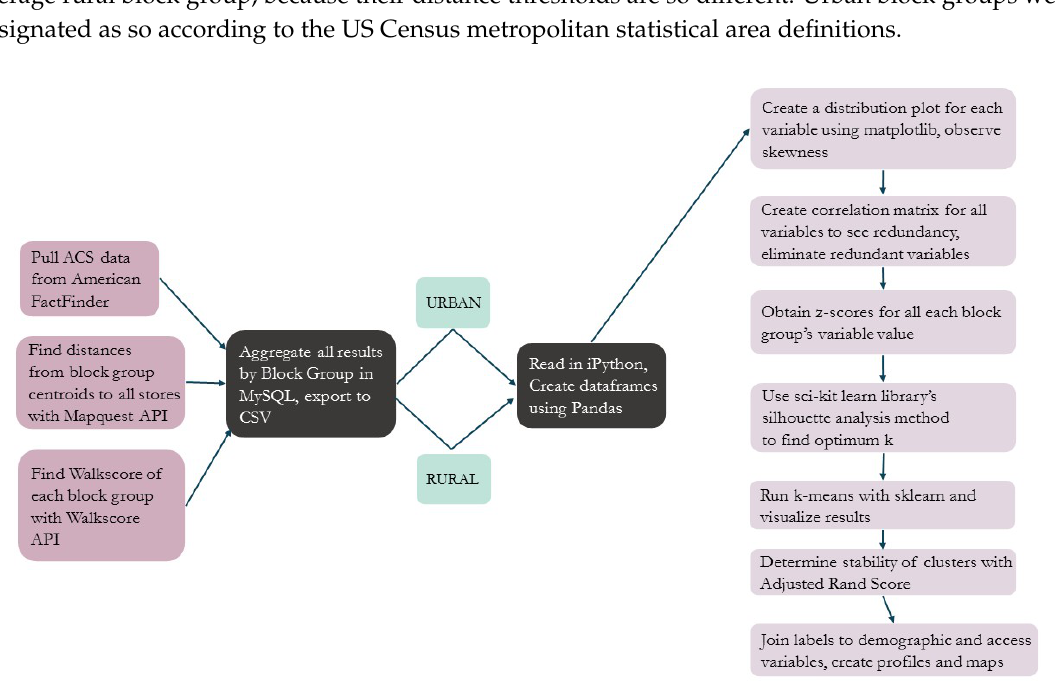
Figure 2. Flowchart of Analytical Procedure.